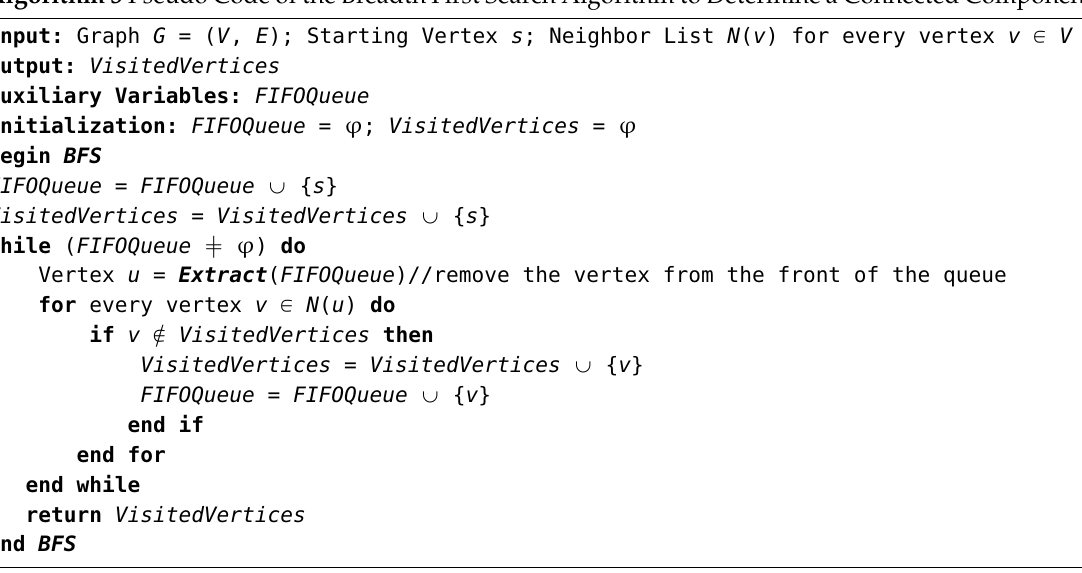
Algorithm 3 Pseudo Code of the Breadth First Search Algorithm to Determine a Connected